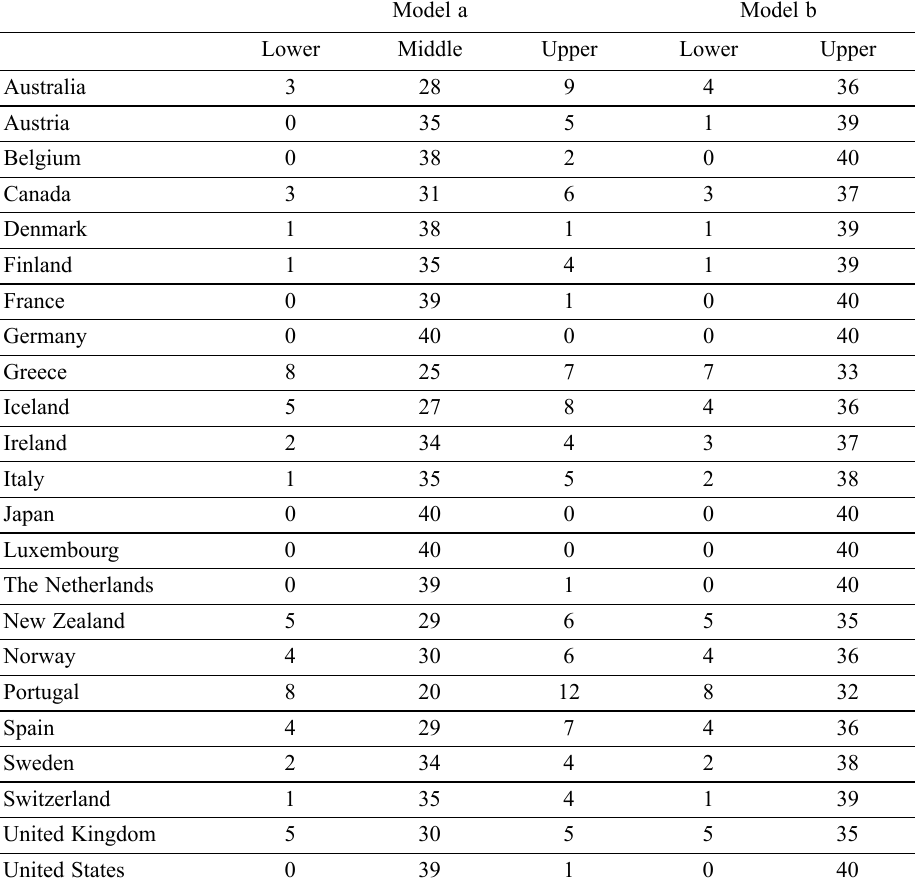
Table A1. Data distribution between regimes and countries Model a Model b Lower Middle Upper Lower